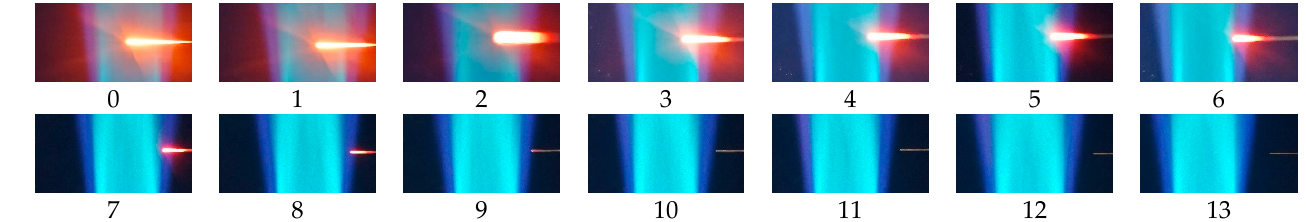
front and I decreased with